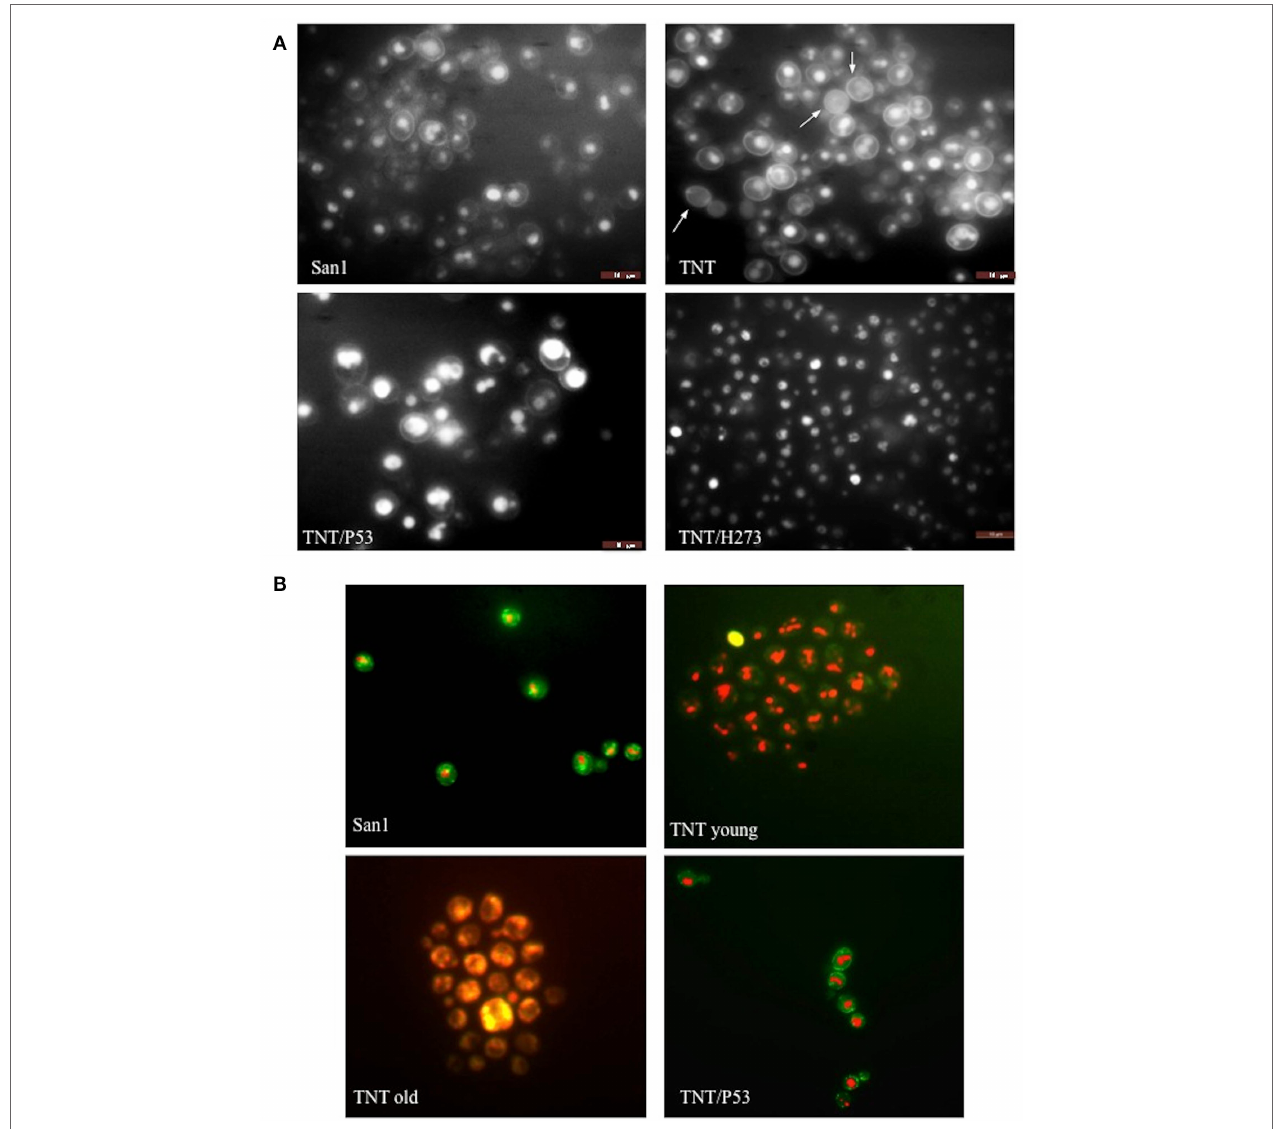
FigUre 7 | Fluorescent microscopy of (a) endocytosis (B) and cell viability. In (a) , lucifer yellow (LY) was used to test endocytosis in the wild type (WT) San1, in TNT cells, in TNTs transformed with P53 (TNT/P53) and with P53 mutated in H273 (TNT/H273). LY gives a high background staining of the cell wall of the translocants with a defective accumulation of the fluorescent molecule in the vacuole. The white arrows indicate cells with almost complete loss of endocytosis (roughly 10% of the cells). P53 restores a good level of endocytosis in the translocants. In (B) , the FUN-1 staining reveals comparable viability of both San1 and the TNT cells transformed with P53. The TNT cells without P53 appeared already suffering when young cultures (2 days old) and very sick when old cultures (3 weeks old). The dead cells are stained in yellow. After 4 weeks, 5% of the cells appeared dead (yellow) and all them appeared as very sick (orange